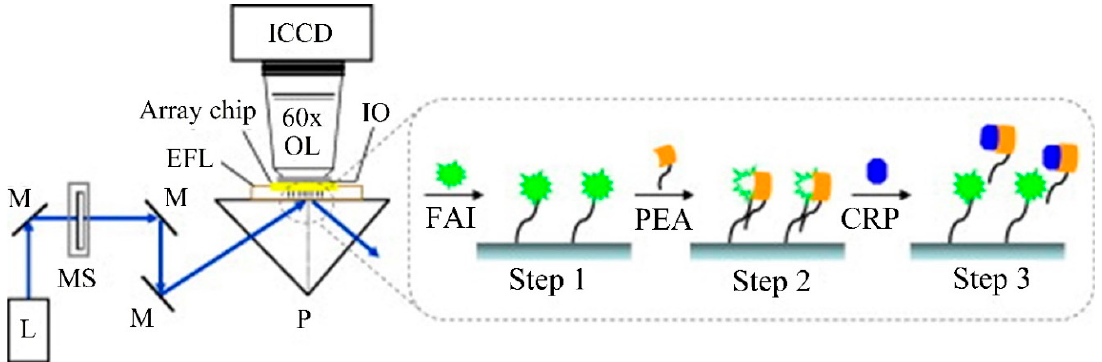
Figure 16. Laboratory-built TIRFM system used for the MSF-based detection of CRP. Key: L, laser; M, mirror; MS, mechanical shutter; P, prism; IO, immersion; OL, objective lens; EFL, evanescence field layer, ICCD, intensified charge-coupled device. Reprinted [150], Copyright 2010, with permission from Elsevier.